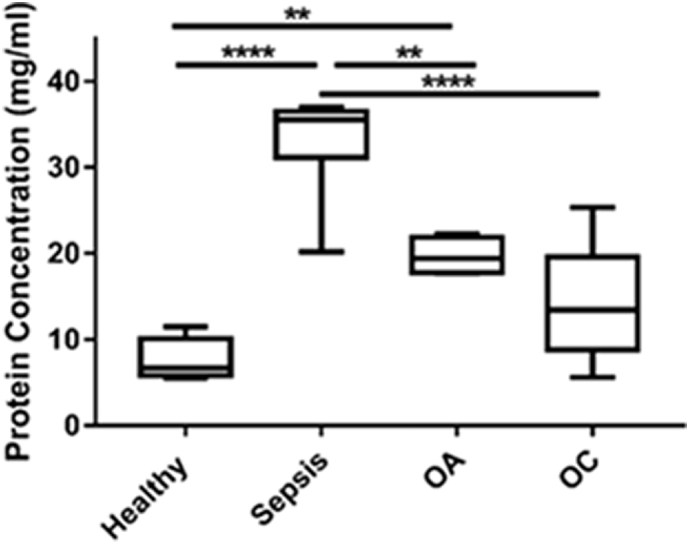
Synovial fluid protein concentrations in equine arthropathies. Protein concentrations of SF were determined by Bradford assay. Healthy (n = 8), OA (n = 4), OC (n = 8), sepsis (n = 7). Significant changes are demonstrated following analysis using ANOVA with Tukey's multiple comparison; ** p < .01, **** p < .0001.